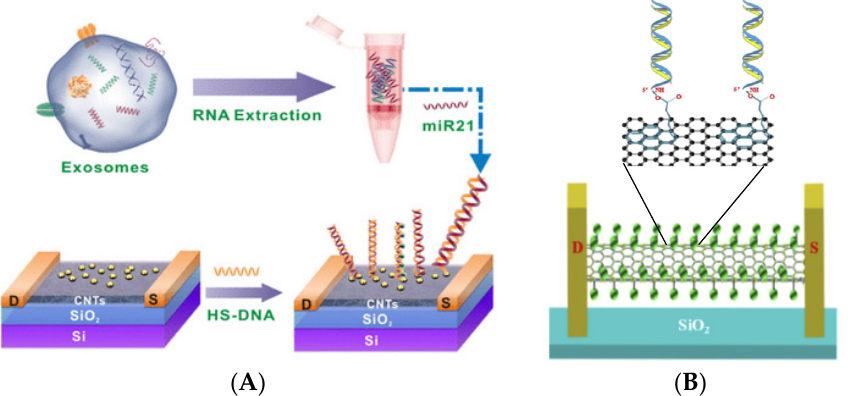
Figure 17. ( A ) Genosensor employing SWCNTs composite as a FET membrane for the detection of miRNA, ( B ) single CNT-based FET sensor based on a “hanging” bridge between the source (S), and drain (D). Adapted with permission from Li et al. [115] (copyright © (2021), ACS) and Sun et al. [116] (copyright © (2019), Elsevier).